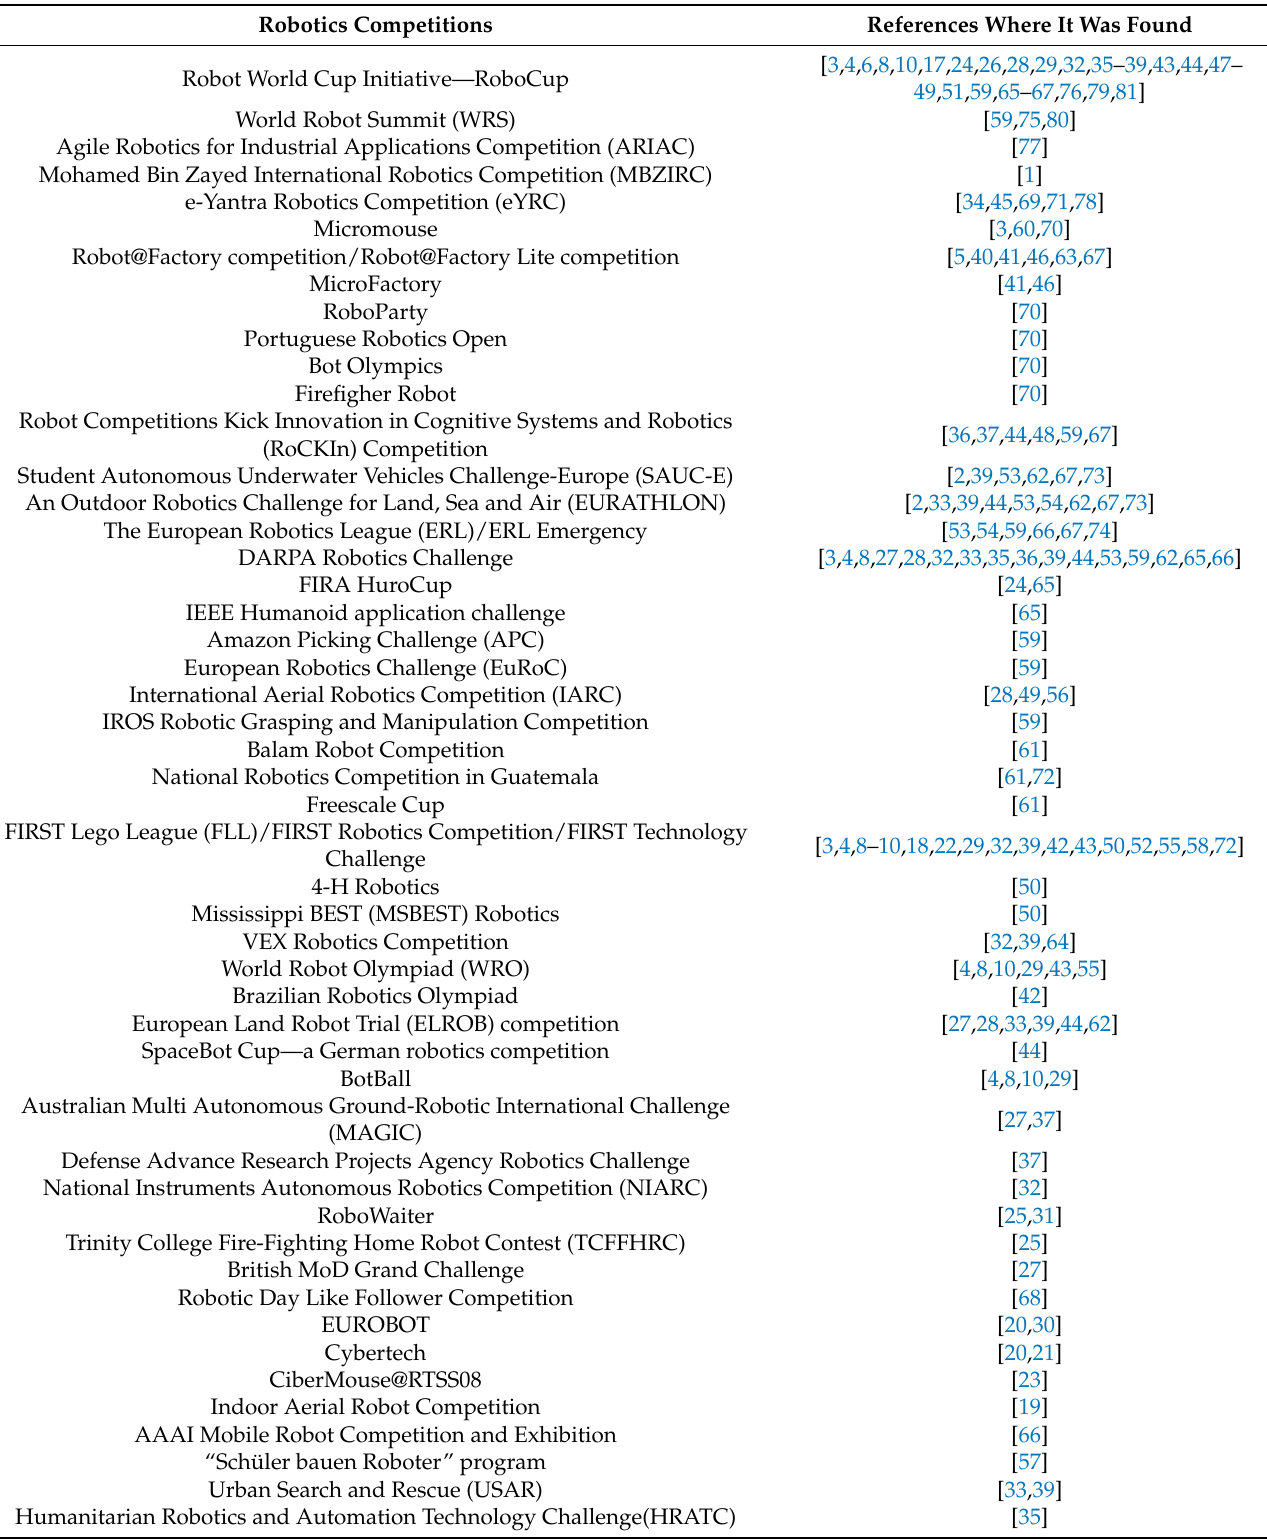
Table 3. All robotics competitions found and their respective